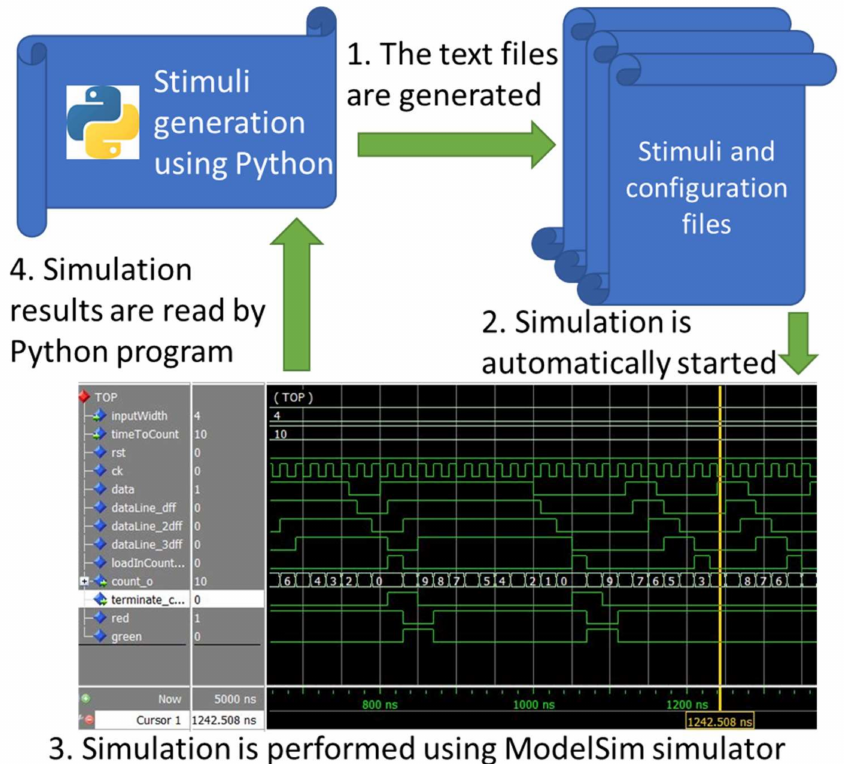
Figure 3. The information processing flow used in the current